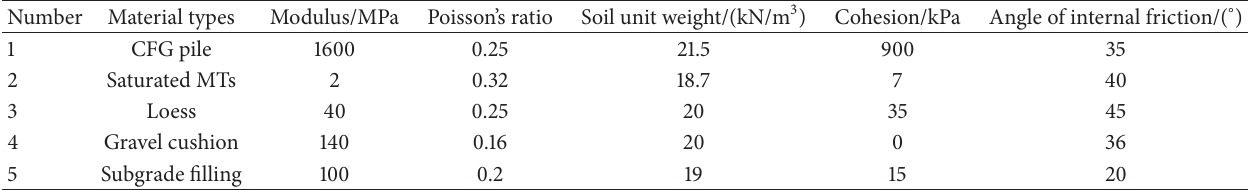
Table 1: Geotechnical properties of CFG pile and soil layers